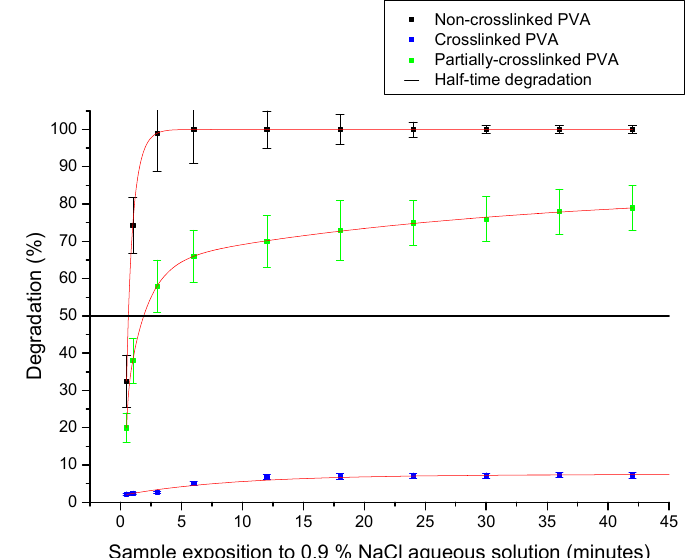
Figure 8. Degradation of crosslinked PVA nanofibers and noncrosslinked PVA nanofibers.